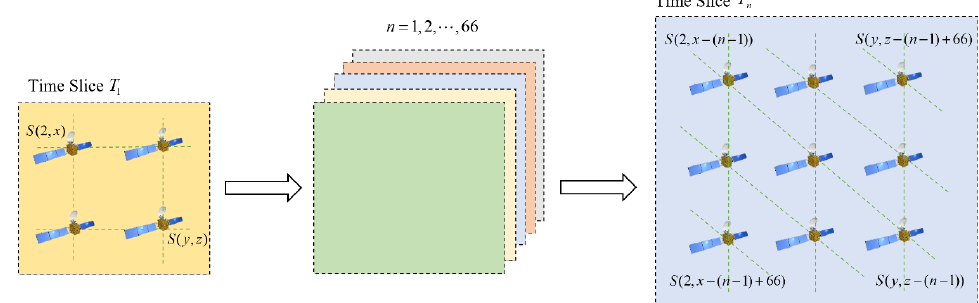
Figure 1. Time slice division method based on the number of satellites per orbit.